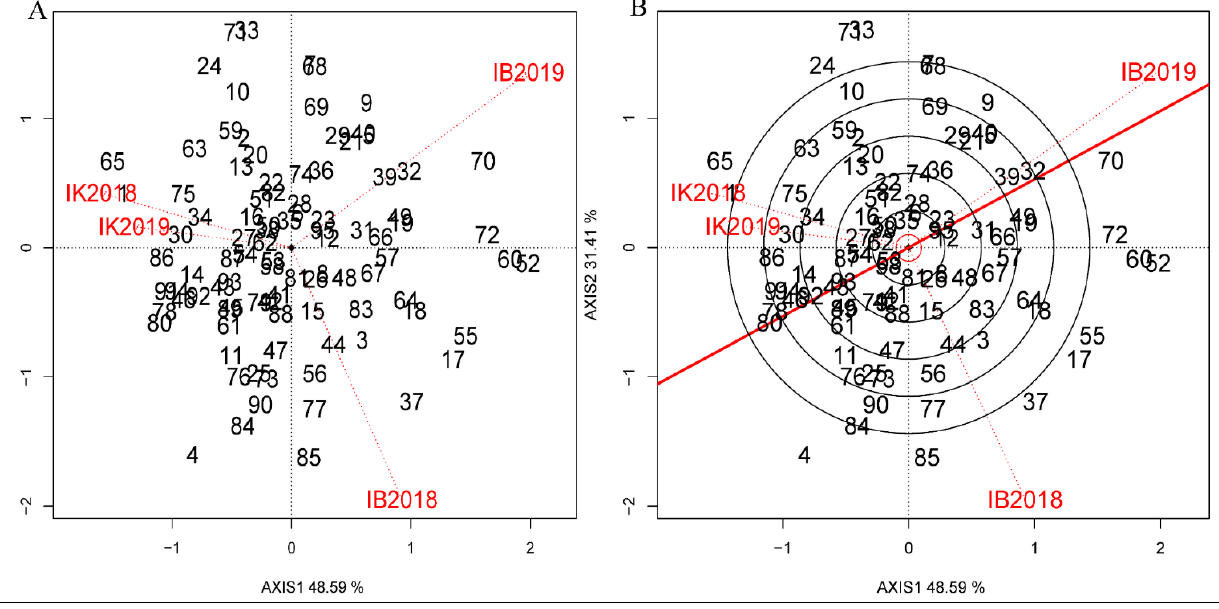
Figure 2. ( A ) Biplot analysis result. ( B ) Discriminativeness and representativeness of the accessions with the environments.